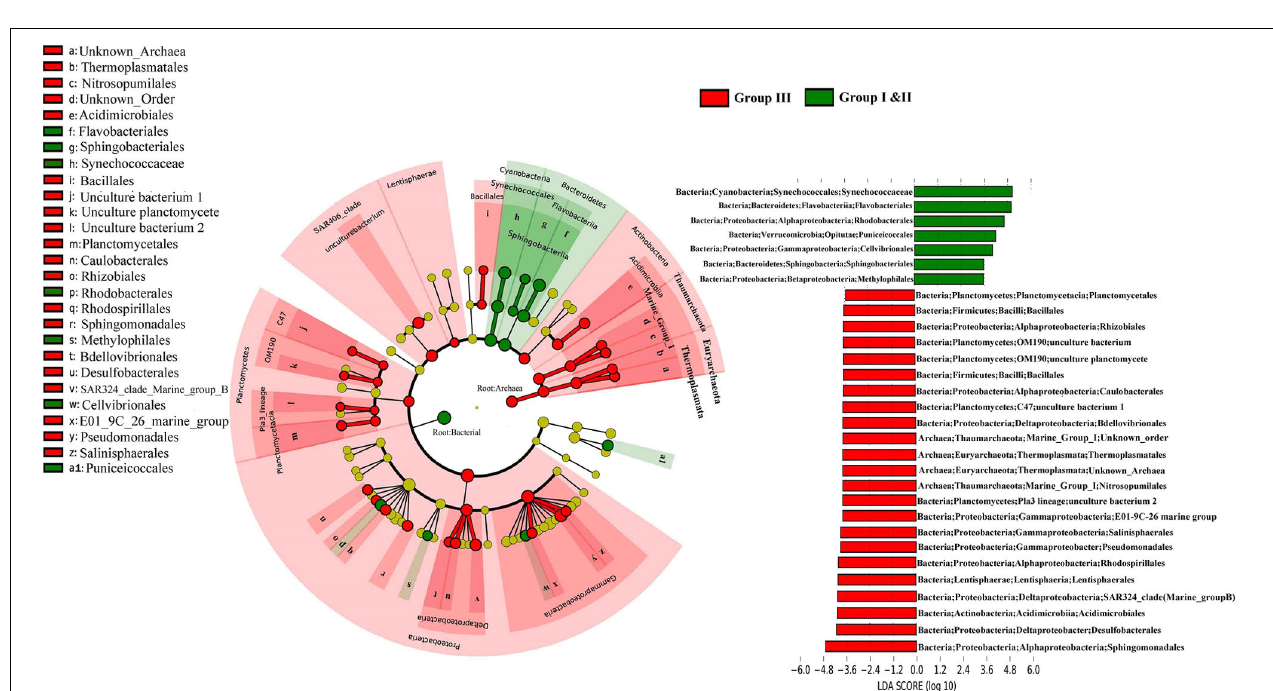
FIGURE 3 | The microbial community composition at the phylum level (left) , and a differential analysis between the surface and deep-water groups (right) . For the differential analysis, values are the base-10 logarithm of the odds ratio, and the positive and negative values indicate that the taxa are more abundant in the deep and surface waters, respectively.